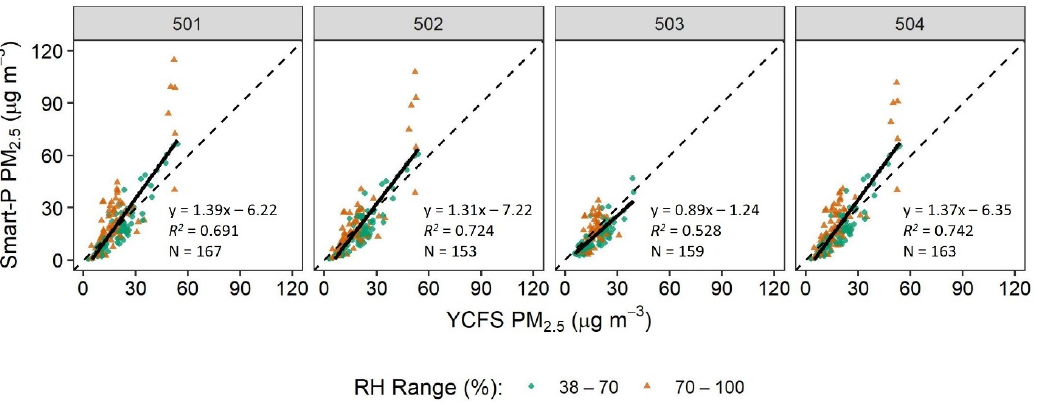
Figure 5. Linear regression (black solid lines) of hourly PM 2.5 concentration of each of the four Smart-P monitors (IDs: 501, 502, 503, and 504) versus the BAM-1020 monitor at the Yale Coastal Field Station (YCFS). Dotted lines are diagonal (1:1) lines.